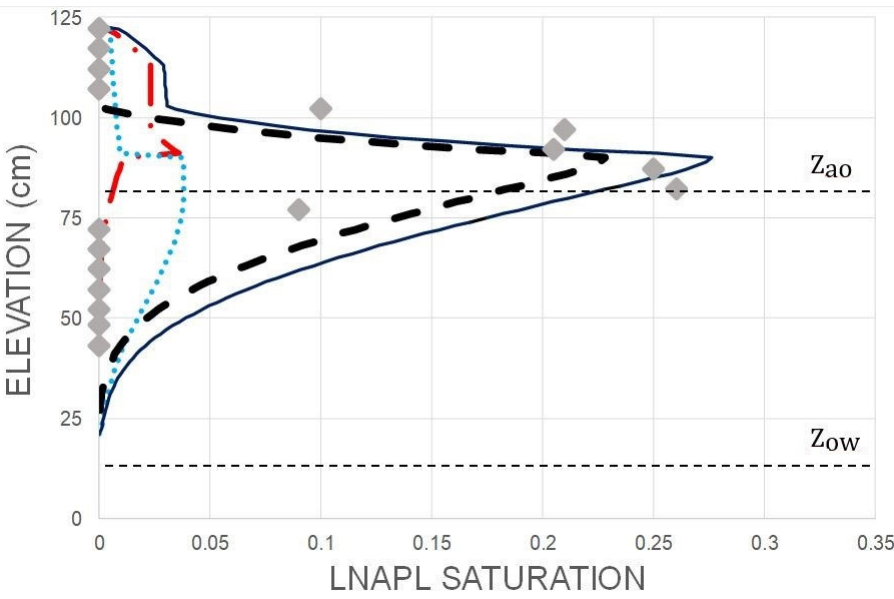
Figure 5. Comparison of measured (grey diamond symbols) and predicted LNAPL saturations using imbibition